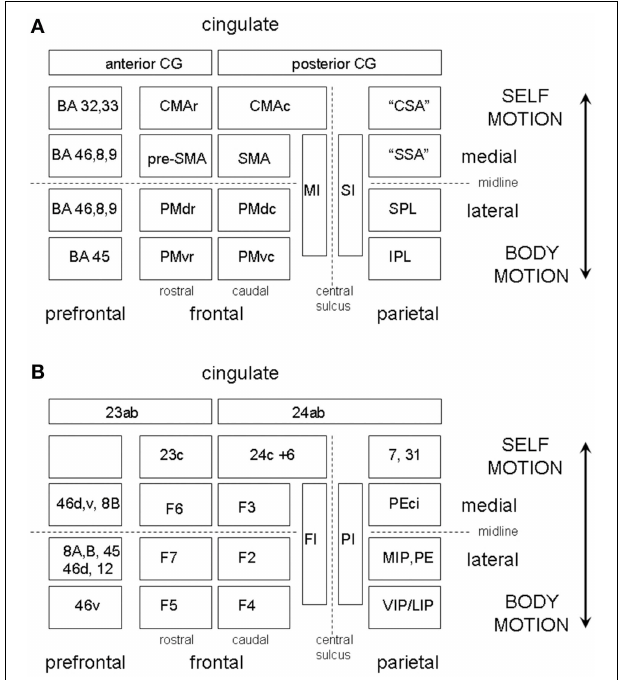
FIGURE 7 | (A) A highly schematic representation of somatotopically organized sensory and motor cortical areas organized on a medial vs. lateral and frontal vs. parietal oriented map of one hemisphere. The map is bounded medially by the cingulate gyrus and frontally by the prefrontal cortex. The frontal areas are further partitioned according to their rostral or caudal location in the map. The PMC is divided into four regions, labeled PMdc, PMdr, PMvc, and PMvr. The SMA/CMA region is similarly partitioned into CMAc, CMAr, pre-SMA, and SMA. The caudal motor areas each have a corresponding parietal receiving area, which we have labeled the “cingulate sensory area” (CSA), the “supplementary sensory area” (SSA), the SPL, and IPL. (B) Shows the same as (A) but with the equivalent non-human primate labels